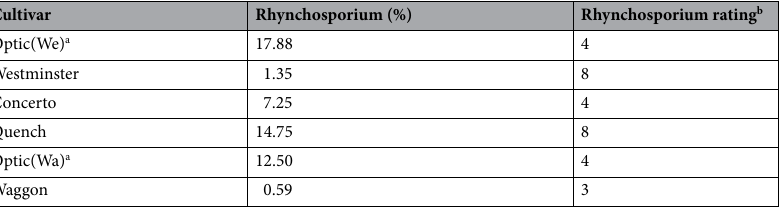
Table 1. Mean disease of spring barley monocultures. a Optic(We) and Optic(Wa) are 100% Optic plots using the seed used in the Westminster and Waggon mixture series respectively. b AHDB 44 Recommended List 2011–12.